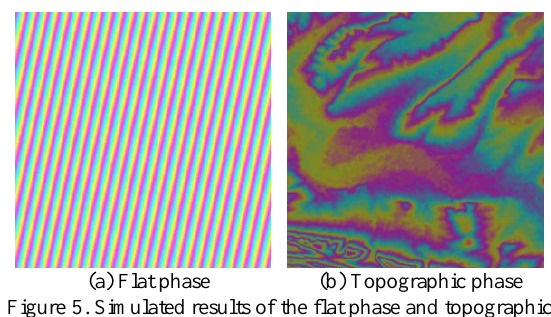
Figure 5. Simulated results of the flat phase and topographic